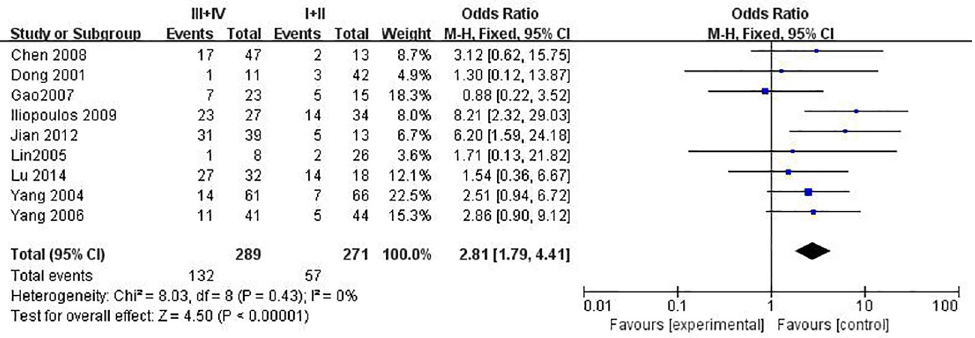
Fig 5. Funnel plots for associations of MGMT promoter hypermethylation with the FIGO stage of cervical cancer. The squares represent the ORs for individual studies. The size of the square reflects the weight of included studies. Bars represent the 95% confidence intervals (CIs). The center of the diamond represents the summary effect